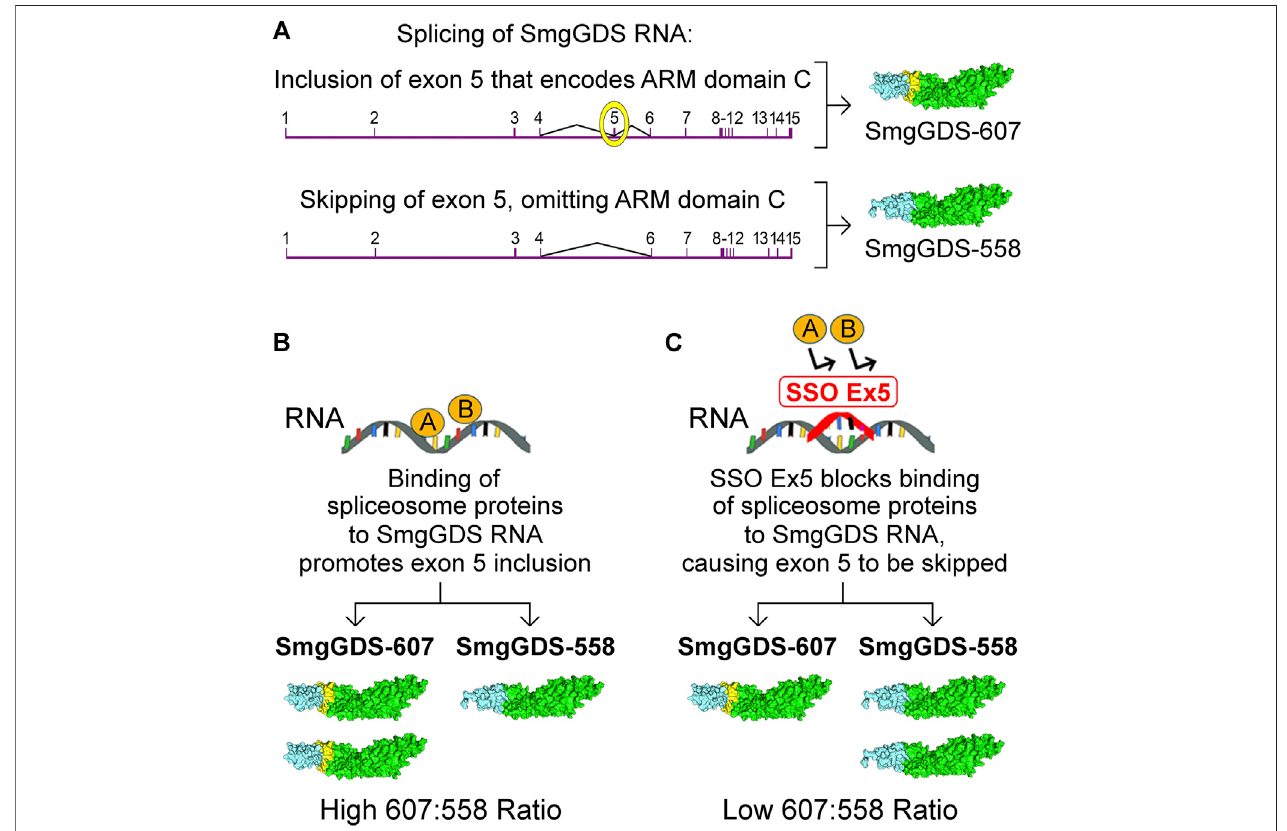
FIGURE 4 | Schematic illustration depicting the regulation of SmgGDS expression by the splice-switching oligonucleotide, SSO Ex5. (A) SmgGDS RNA contains 15exons,andexon5encodesARMdomainC.Inclusionofexon5inmatureSmgGDSmRNAgeneratesSmgGDS-607,whereasomissionofexon5inmatureSmgGDS mRNA generates SmgGDS-558. (B) In cancer cells, the binding of unspeci fi ed spliceosome proteins to SmgGDS RNA promotes exon 5 inclusion and generates more SmgGDS-607 than SmgGDS-558. (C) Binding of SSO Ex5 to SmgGDS RNA promotes exon 5 skipping, generating more SmgGDS-558 than SmgGDS-607. Additional manuscript